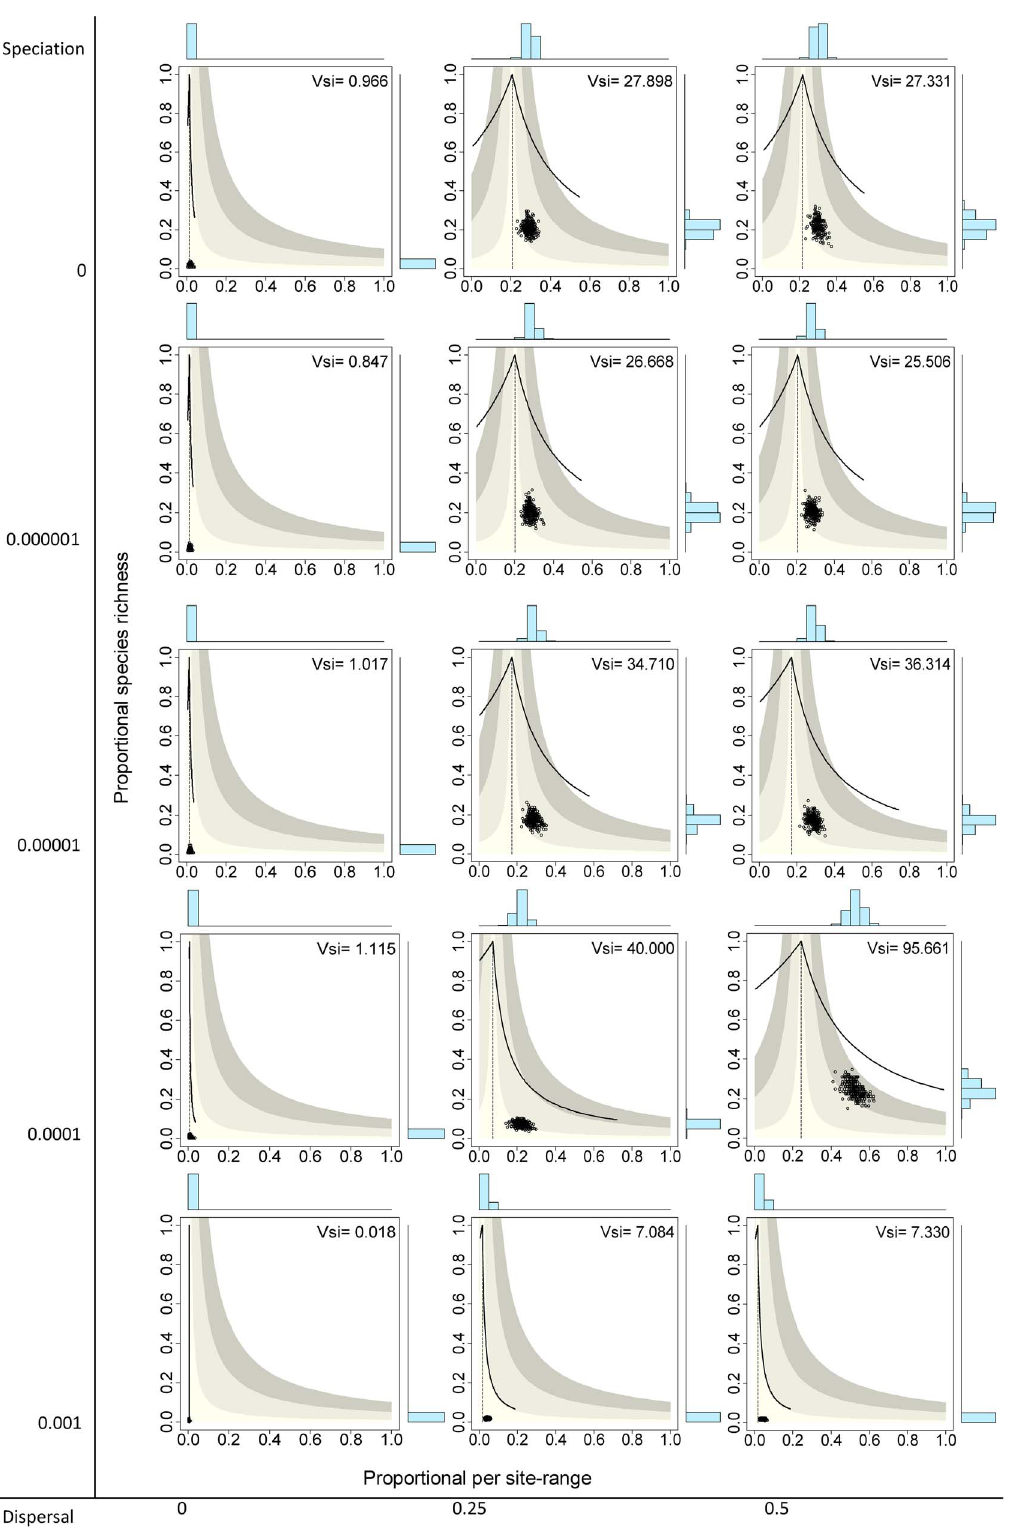
Figure 4. Range-diversity plots by sites for different combinations of the speciation and dispersal parameters in neutral models. Information as in Figure 2B.